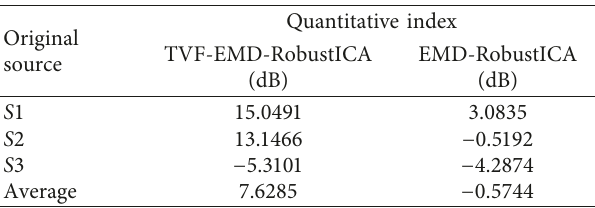
Table 3: Quantitative index on the performance of the TVF-EMD- RobustICA and EMD-RobustICA methods.